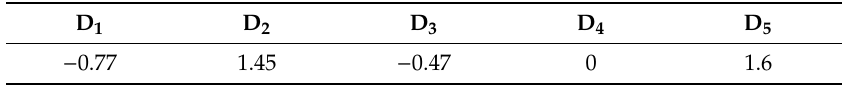
Table 4. AA6061-T6 Johnson–Cook failure parameters Table 4. AA6061 ‐ T6 Johnson–Cook failure parameters [50].